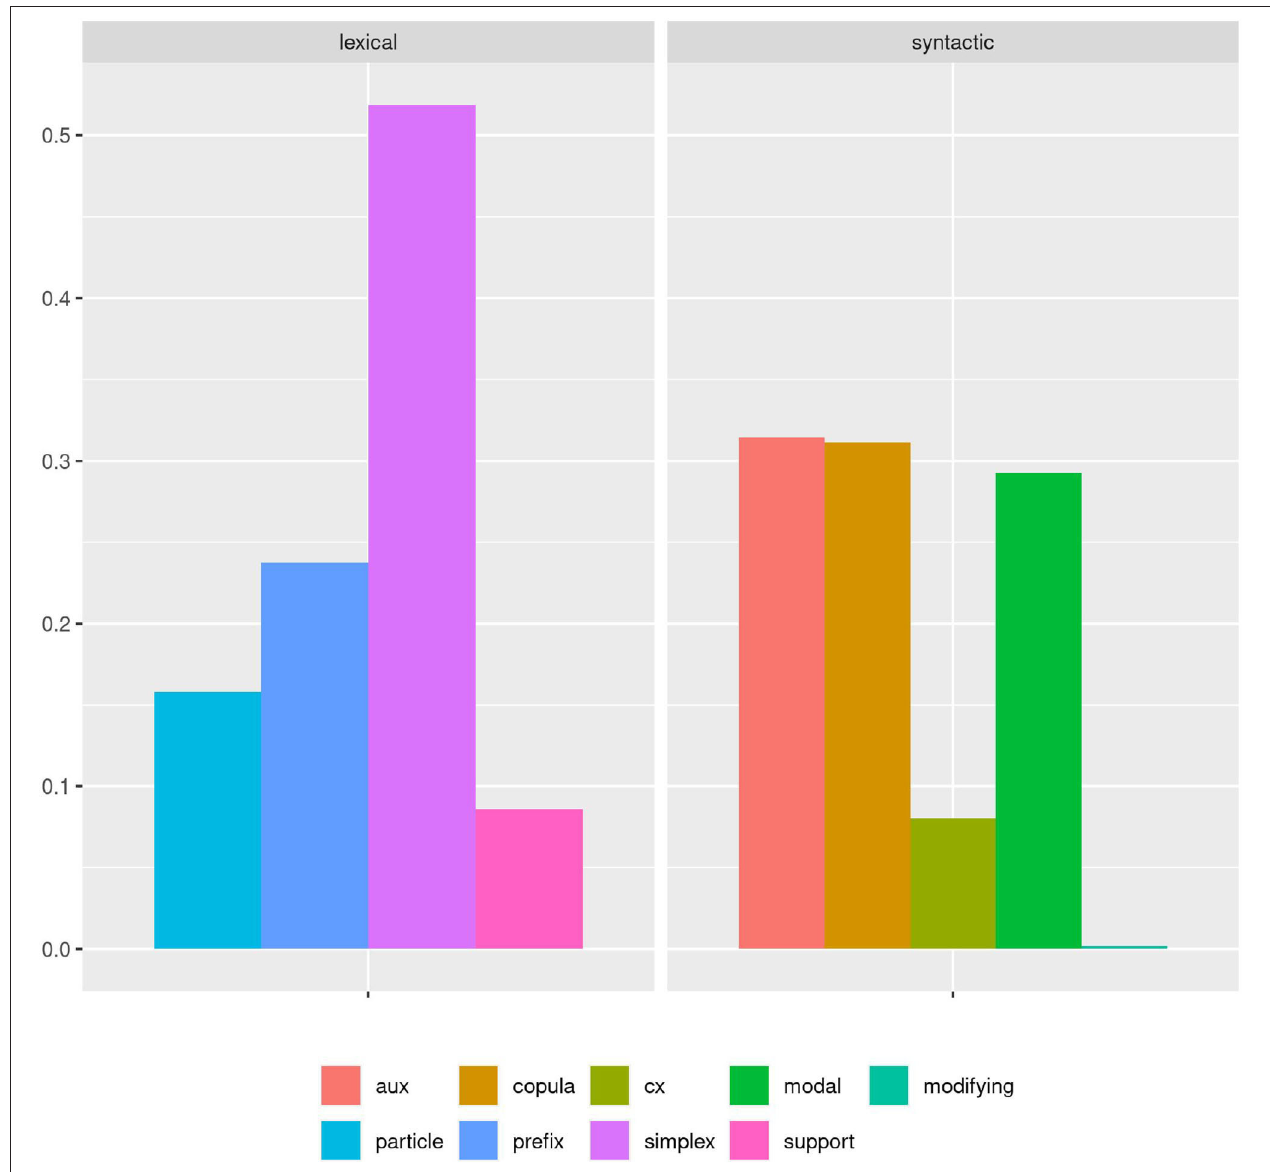
FIGURE 1 | A simple bar plot of cumulative proportions of each verb subclass shows a clear ranking among lexical verbs, with simplex verbs covering more than twice as many cases as particle and prefix verbs. Among syntactic verbs, modal, copula, and auxiliary verbs are nearly equally represented in the cumulative view.